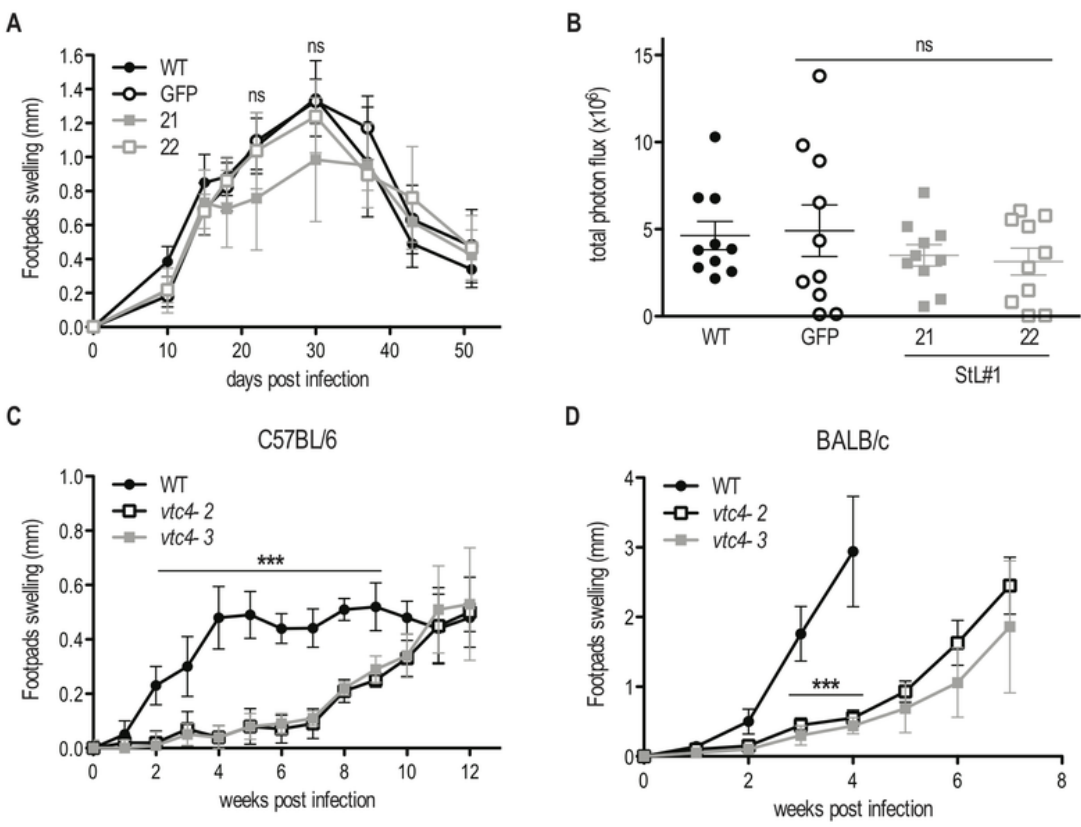
FIGURE 7: In vivo infection with VTC4 knockdown and knockout Leishmania . (A) C57BL/6 mice hind footpads were infected with 3 x 10 6 late stationary phase L. guyanensis parasites and disease progression was monitored by measuring footpad swelling over time. (B) Parasite load was quantified by in vivo imaging (Xenogen) measuring the luminescence signal (photon flux/10min/footpad). (C) C57BL/6 or (D) BALB/c mice hind footpads were infected with 3 x 10 6 late stationary phase L. major parasites and disease progression was monitored by measuring footpad swelling over time. Results of a pool of 2 independent experiments (A and B) or one representative of 3 independent experiments (C and D) were expressed as mean ± SD (n ≥ 5). Statistical significance was assessed by Repeated measure ANOVA (A and C) or Student’s t-test (B and D) ; ***p < 0.001, ns: